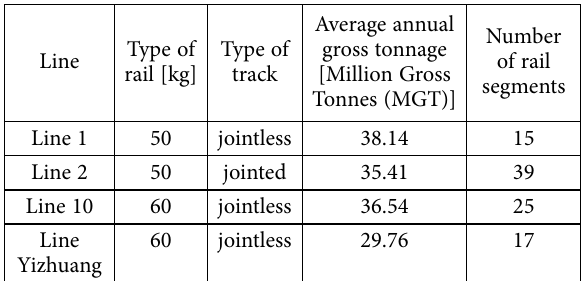
Table 4. The 96 rail segments considered, from four lines